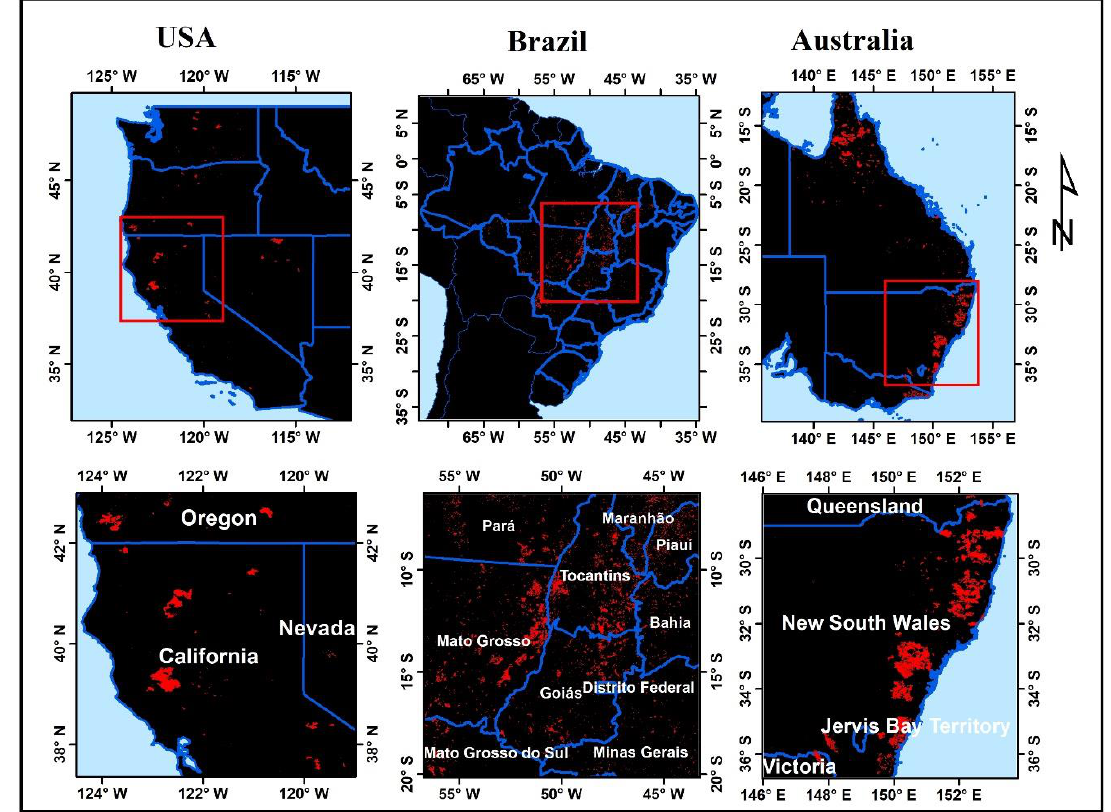
Figure 4. The spatial distribution of fire scars (red) in the western USA (i.e., August–September 2018), Brazil (i.e., August–September 2019) and eastern Australia (i.e., November–December 2019) study sites.